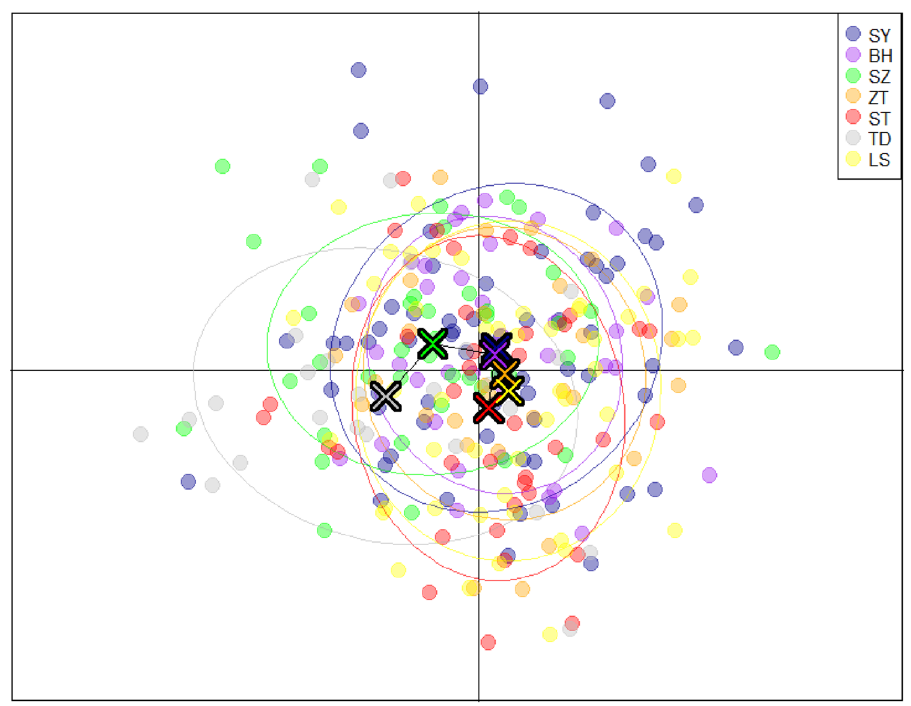
Figure 7. Discriminant analysis of principal components (DAPC), showing relationships among six populations of Trichiurus nanhaiensis clusters based on thirteen microsatellite loci LYG Lianyungang,